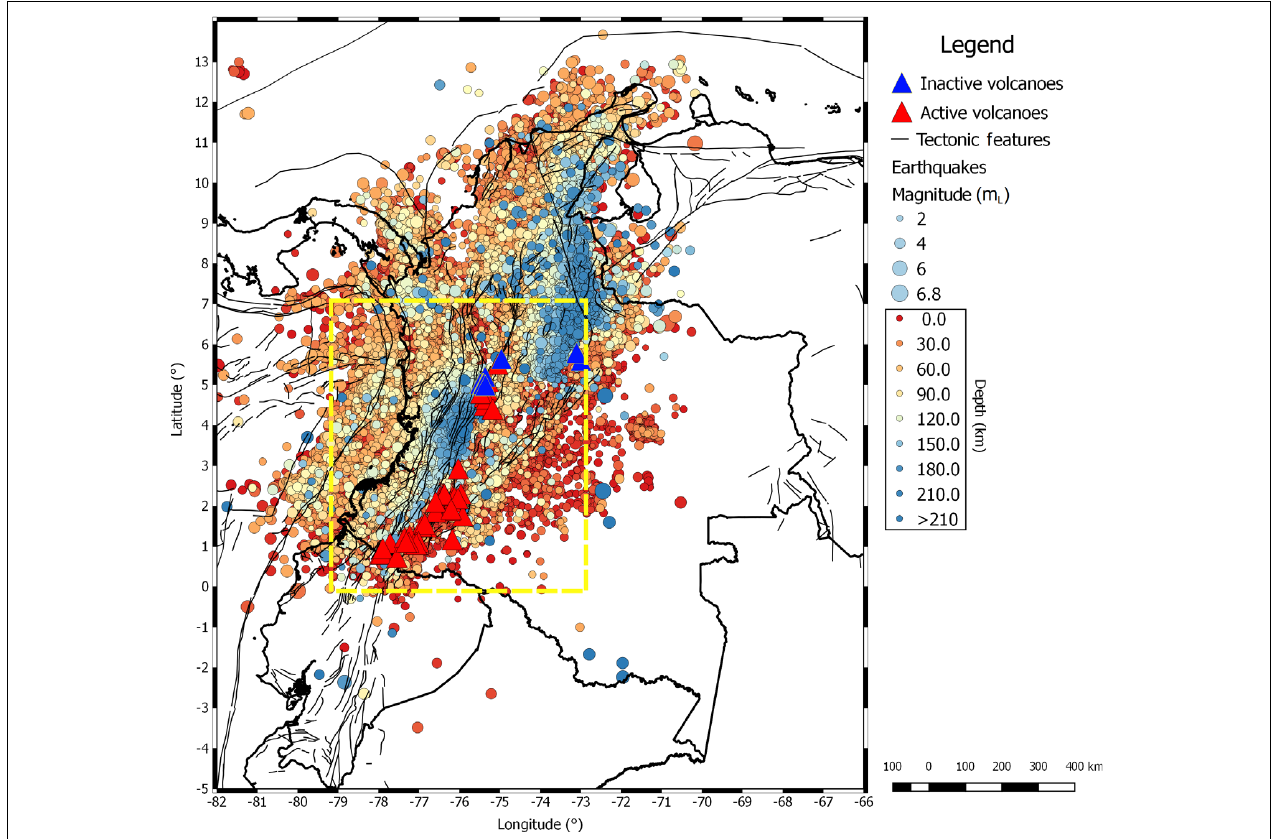
FIGURE 2 | Distribution of earthquakes recorded by the Servicio Geológico Colombiano between 1993–2018. In the map have been represented tectonic features (black lines), the volcanic arc of the Northern Andes (red and blue triangles), and the study zone where was performed the seismic attenuation tomography presented in this work (yellow dashed line).